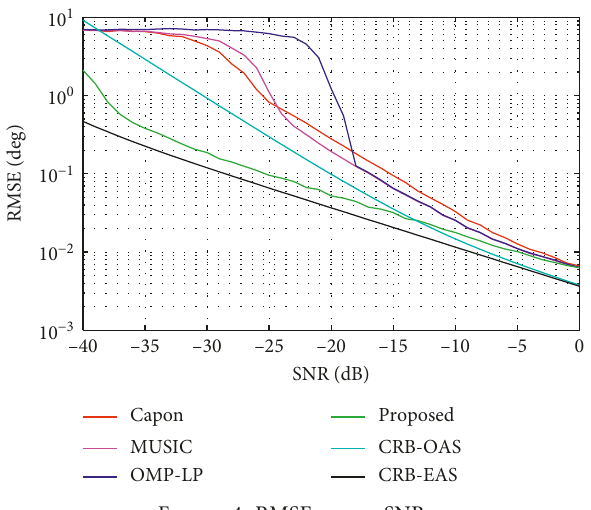
Figure 4: RMSE versus SNR.